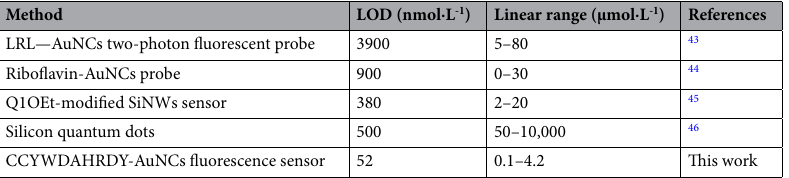
Table 1. comparson with other detection methods.